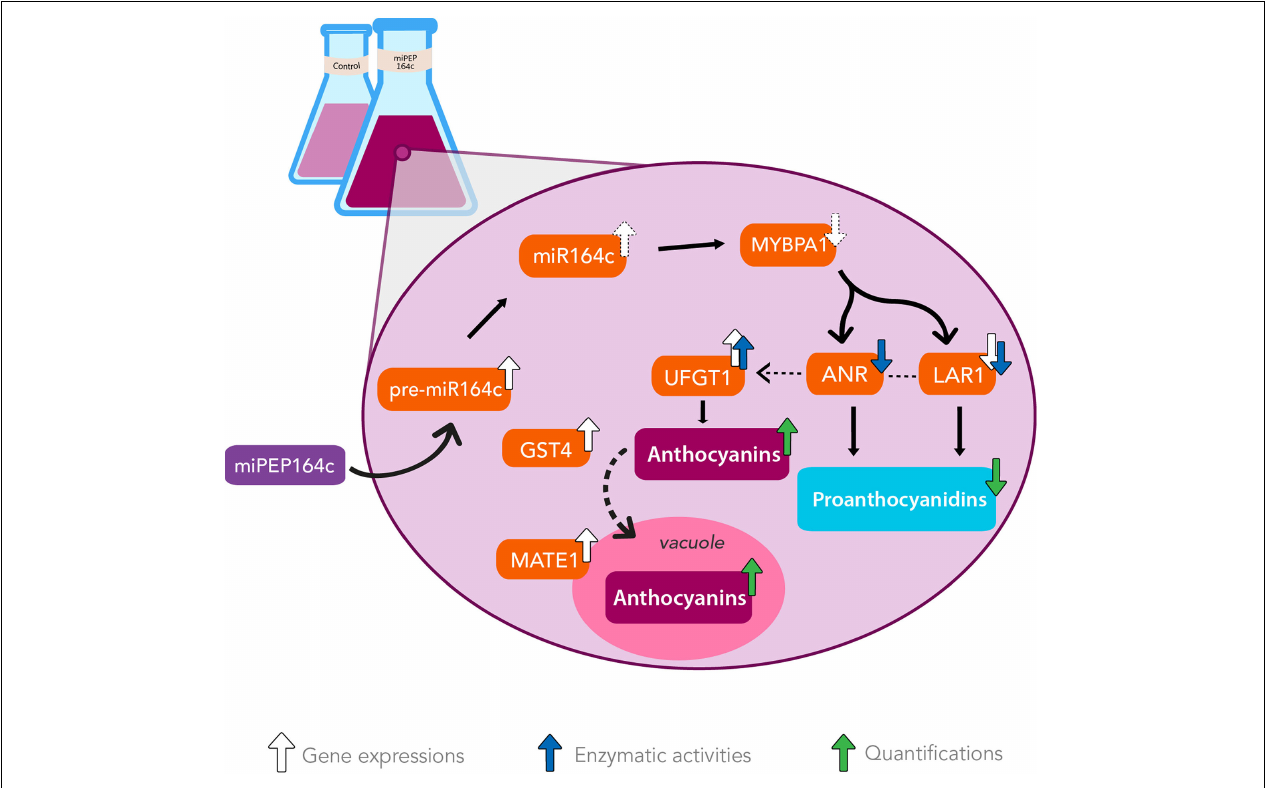
FIGURE 8 | The exogenous application of miPEP164c increases anthocyanin synthesis and accumulation while decreasing PA synthesis by enhancing miR164c -mediated downregulation of PA-synthetic pathway in Gamay grape berry cell suspensions. Addition of miPEP164c provoked an increase in the transcription of pre-miR164c and consequently of its mature form, miR164c, which putatively led to a decrease in the translation of transcription factor MYBPA1. This inhibition in MYBPA1 translation resulted in a downregulation of VvLAR1 expression and LAR total biochemical activity, as well as ANR total biochemical activity, decreasing the intracellular concentration of PAs. This downregulation of the PA pathway indirectly led to the stimulation of the anthocyanin synthesis by increasing VvUFGT1 expression and UFGT total biochemical activity, as well as vacuolar accumulation, as shown by VvGST4 and VvMATE1